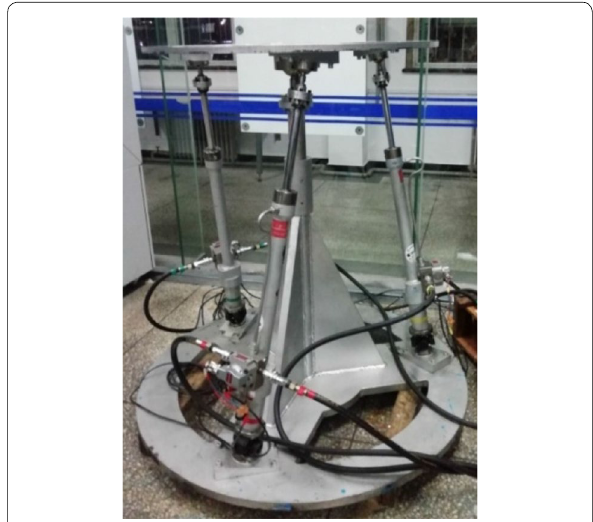
Figure 8 Mechanical structure of the hydraulic driven 3UPS/S